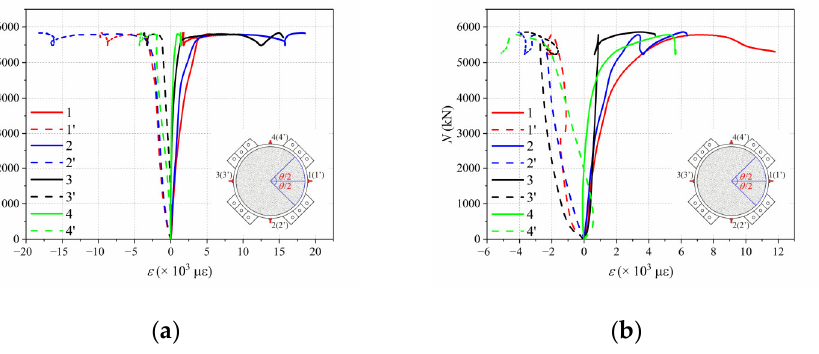
Figure 12. N - ε curves at the cross-section of a 1/2 height of BWCFST specimens with interfacial gap of different θ : ( a ) θ = 90 ◦ ; ( b ) θ = 180 ◦ ; ( c ) θ = 270 ◦